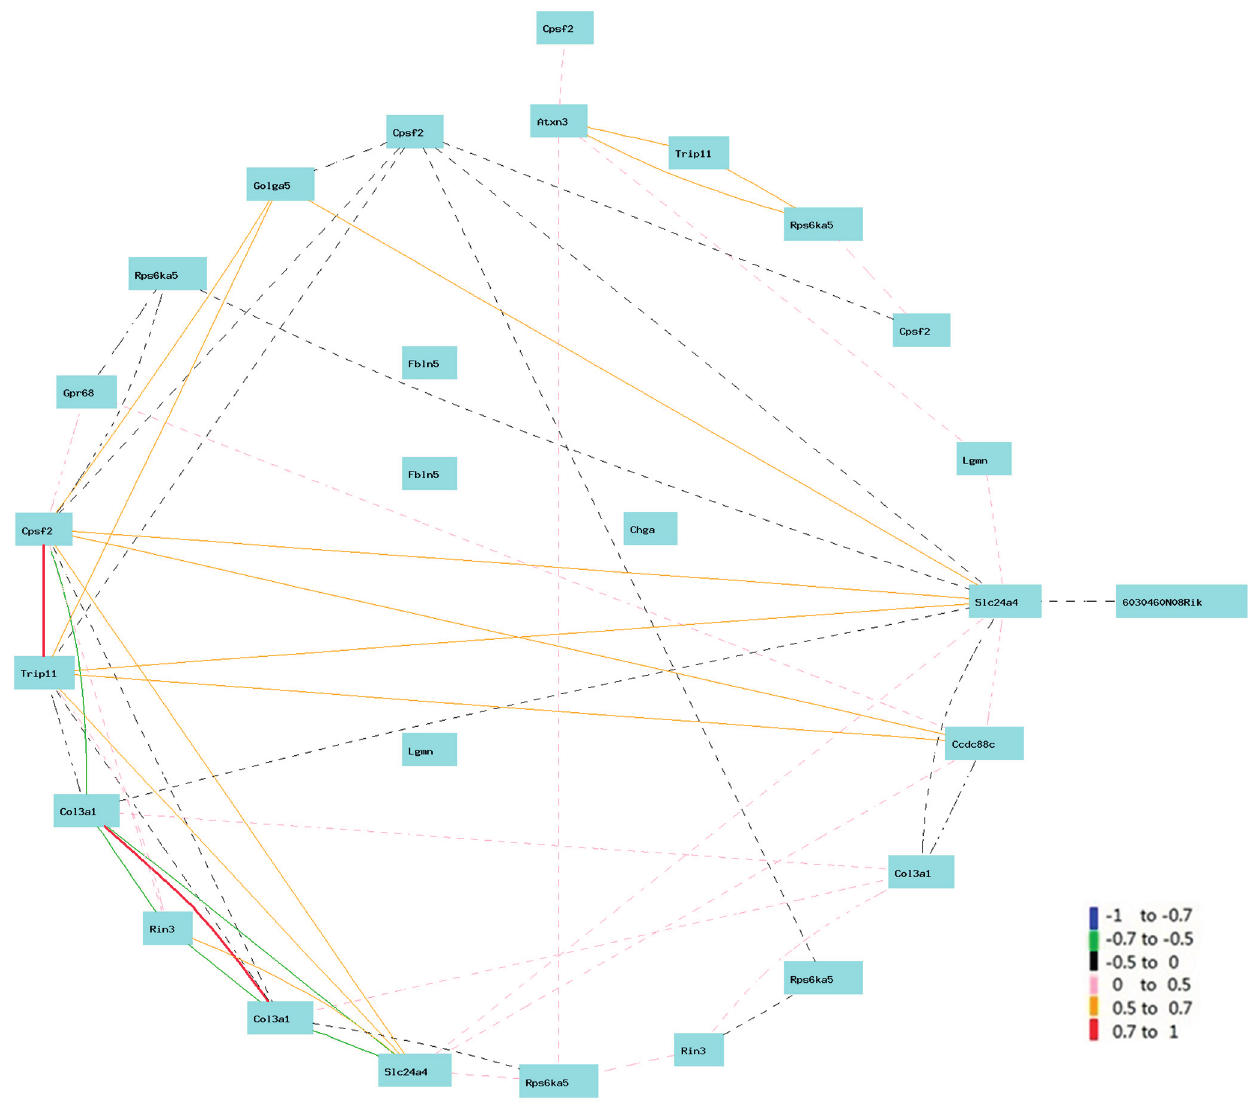
Figure 2. Gene network between Col3a1 and candidate genes on Chr 12. The 27 nodes in the graph below show the selected traits. All nodes are displayed. The 55 edges between the nodes, filtered from the 351 total edges and drawn as curves, show Pearson correlation coefficients greater than 0.35 or less than − 0.35. The graph’s canvas is 40.0 by 40.0 cm, and the node labels are drawn with a 18.0 point font, and the edge labels are drawn with a 16.0 point